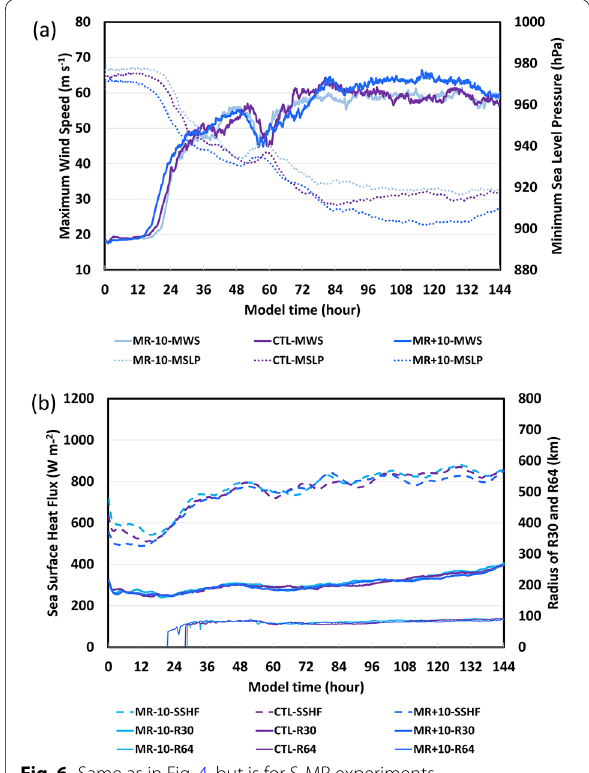
Fig. 6 Same as in Fig. 4, but is for S‑MR